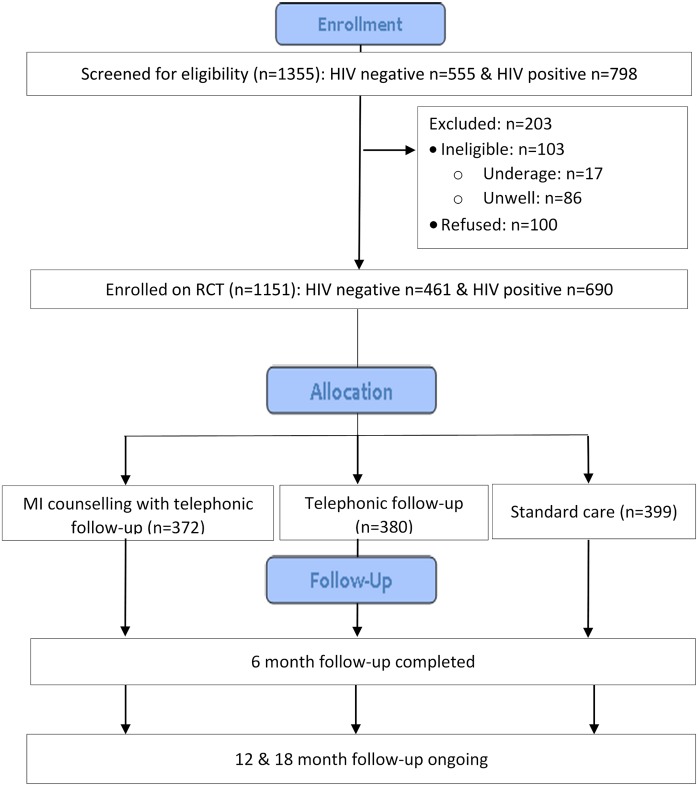
CONSORT diagram of participant enrolment and follow-up in the parent study (RCT).